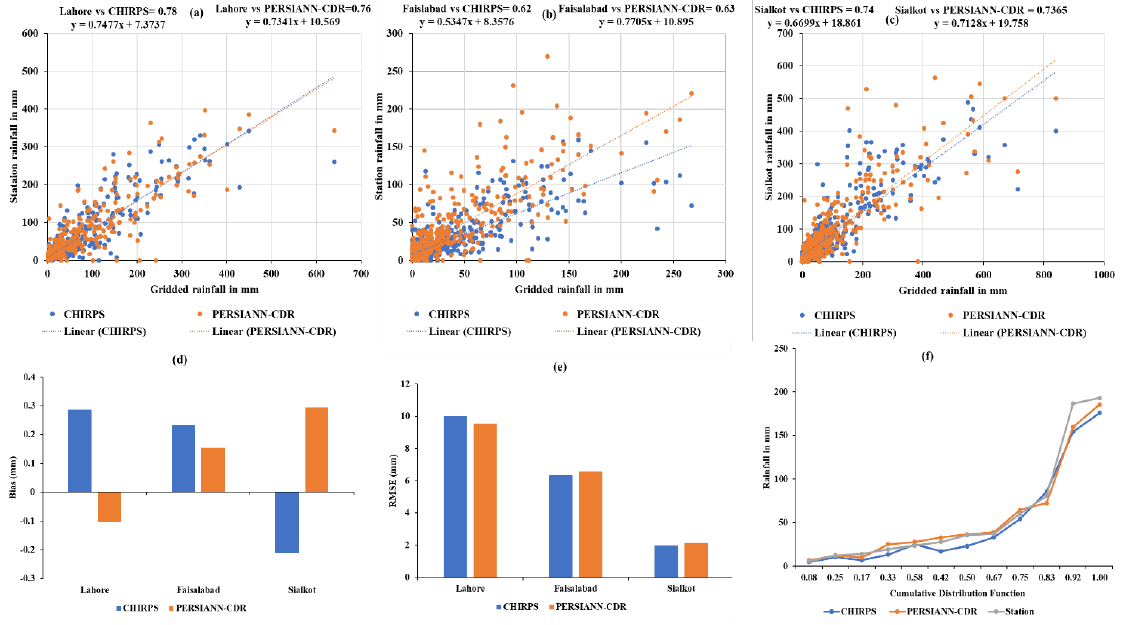
Figure 2. ( a – c ) show the relationship between the observed and gridded data (r 2 ), ( d ) bias, ( e )